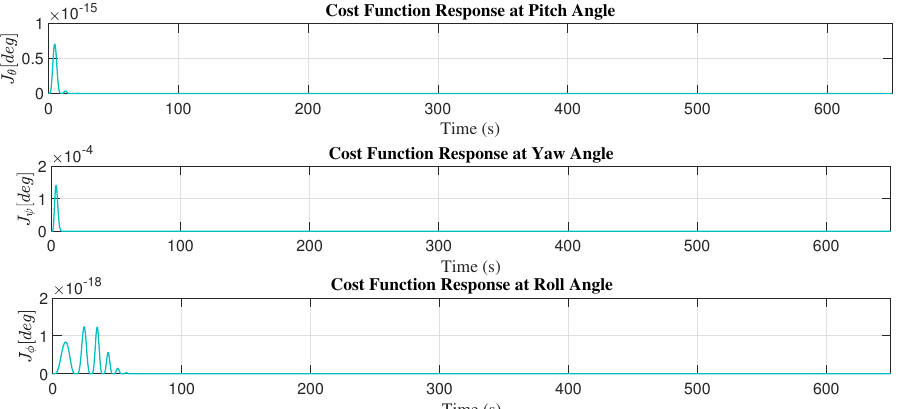
Figure 23. Controller response with MIT rule.